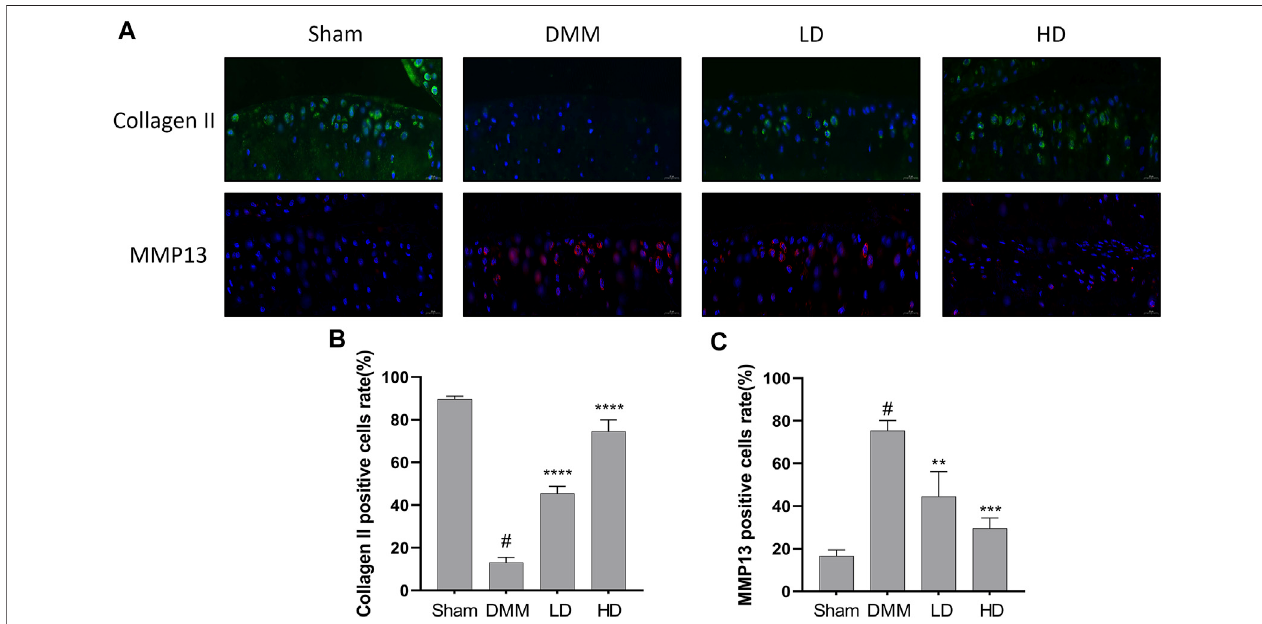
FIGURE6| ProtectivecharacteristicsofCEPinamurineOAmodel.Immuno fl uorescenceforantibodyagainstcollagenIIandMMP13 (A) ,andquantitativeanalysis (B,C) . Green, collagen II; Red, MMP13; Blue, DAPI. Scale bar = 20 μ m. LD and HD represent the dose of 5 and 15 mg/kg CEP, respectively. Values are expressed as mean ± SD, n = 6. # p < 0.05 vs. sham group, ** p < 0.01, *** p < 0.001, and **** p < 0.0001 vs. OA group.